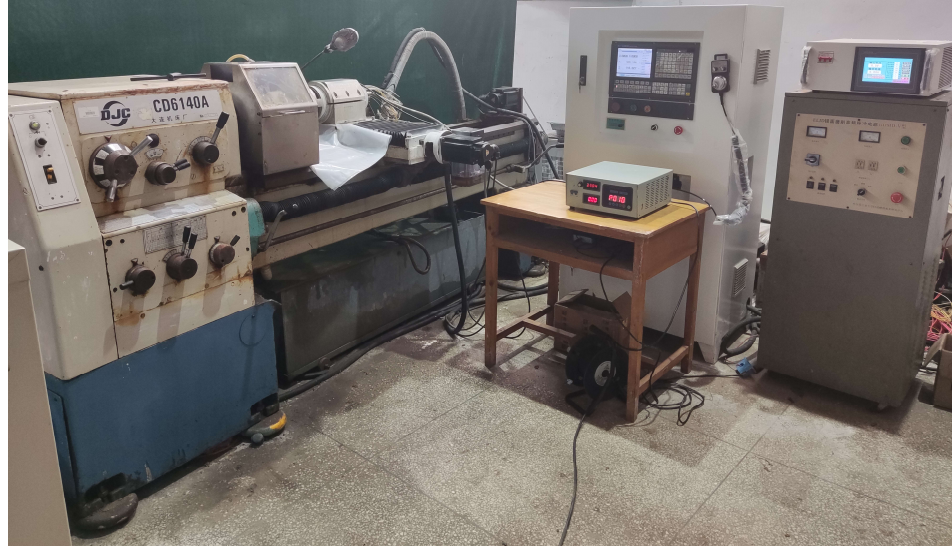
Figure 10. The special machine tool for ICUAECG.